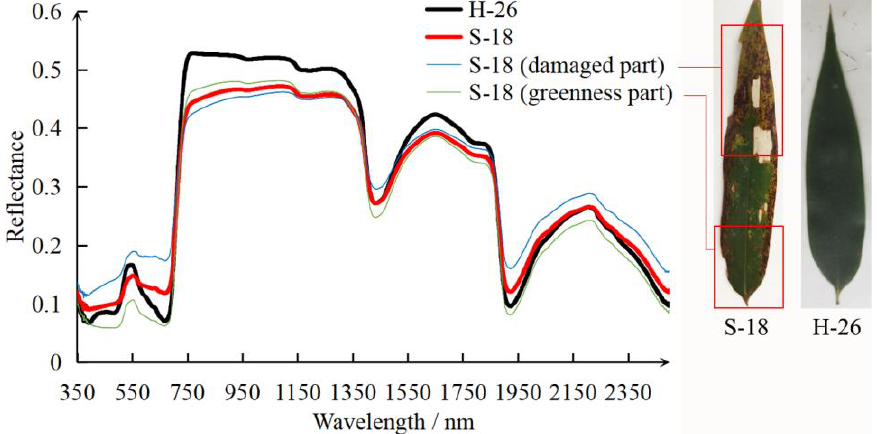
Figure 8. The spectrum difference between damaged and green parts of a leaf (S-18) and spectrum of a healthy leaf (H-26) shown for the purpose of comparison.